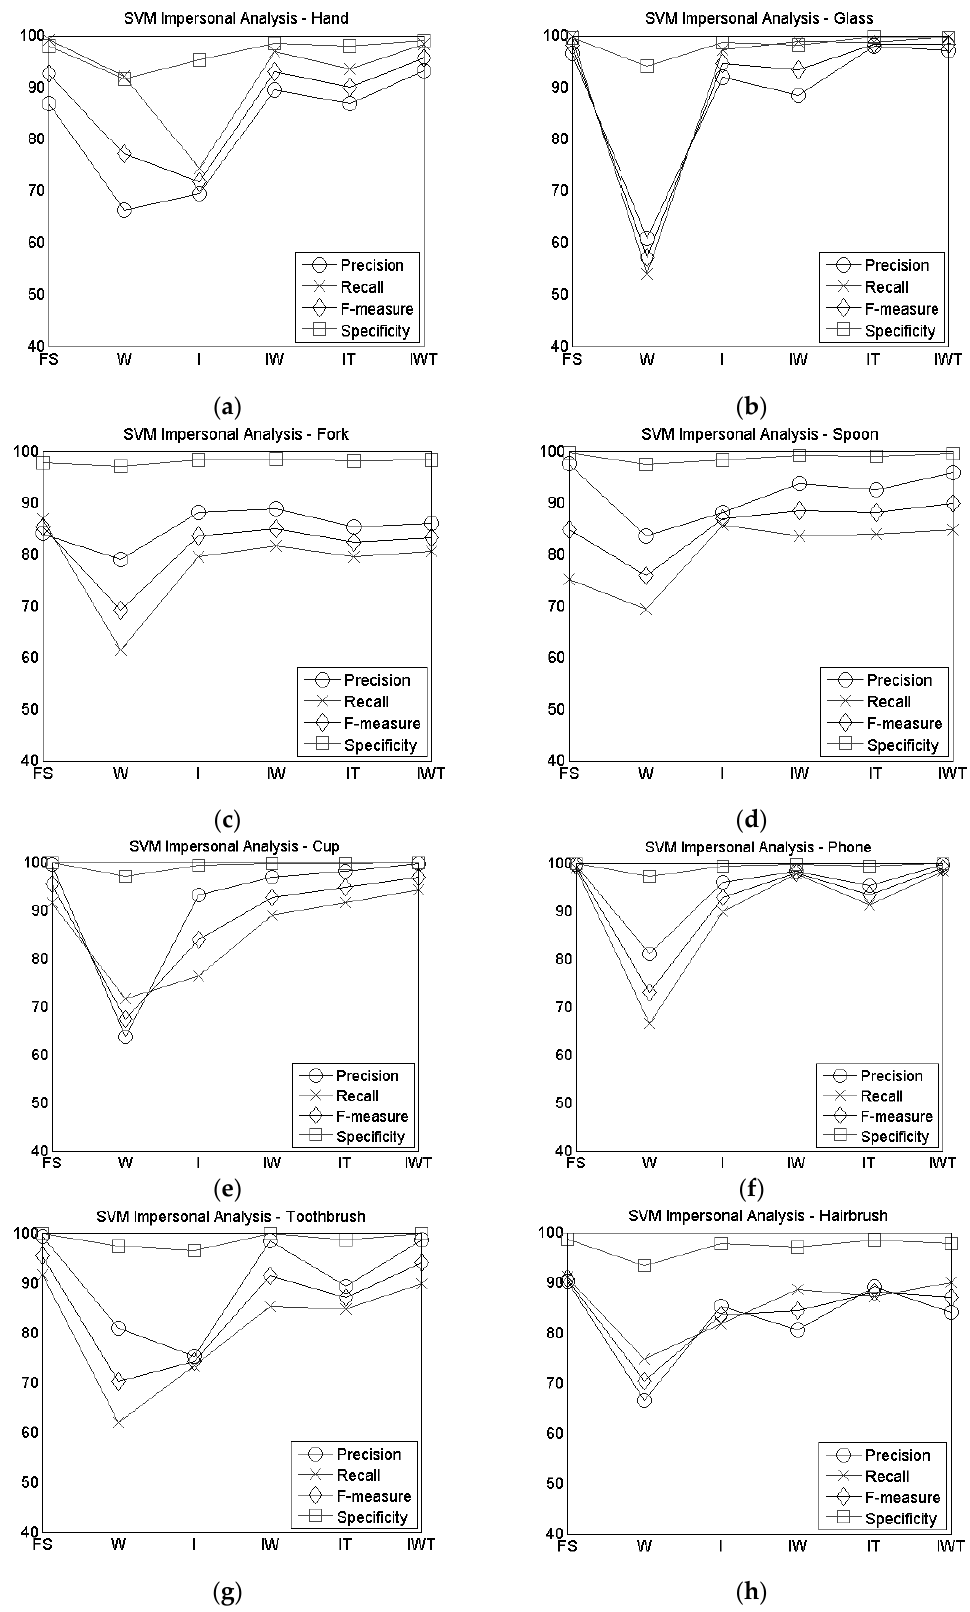
Figure 6. Cont. Figure 6.